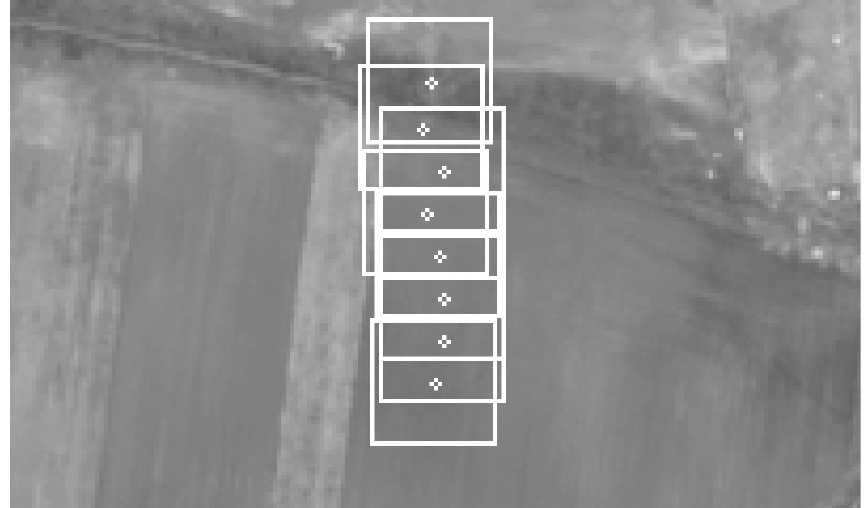
Figure 16. Flight test results. TM cycle merged into one image.